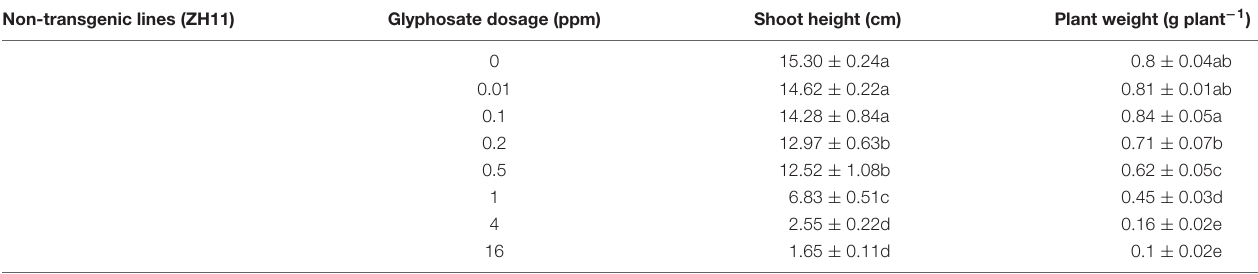
TABLE 2 | Hydroponic growth phenotype of non-transgenic lines under different glyphosate treatments. Non-transgenic lines (ZH11)